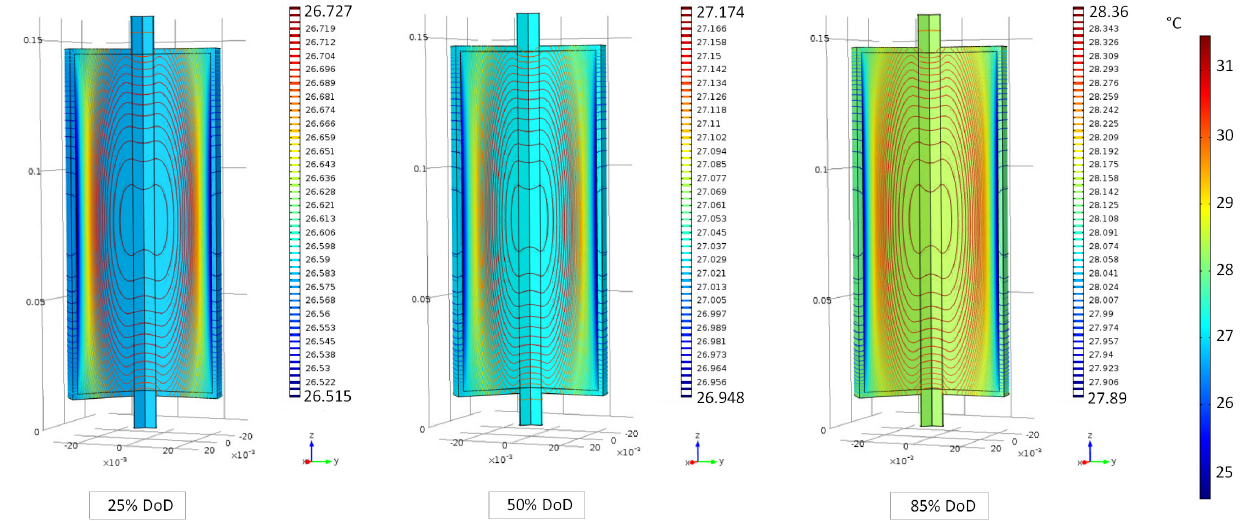
Figure 11. Temperature distributions during a 3 I internal